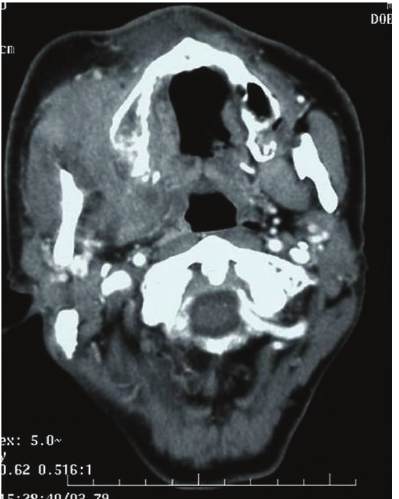
Figure5:Tumorcenteredontherightmaxillarysinusinfiltratedthe subcutis, right orbit, pterygopalatine fossa and ethmoid sinus.